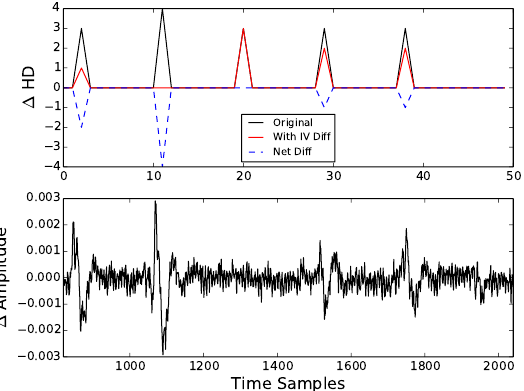
Figure 17: Investigating ∆ HD difference for a sequence of